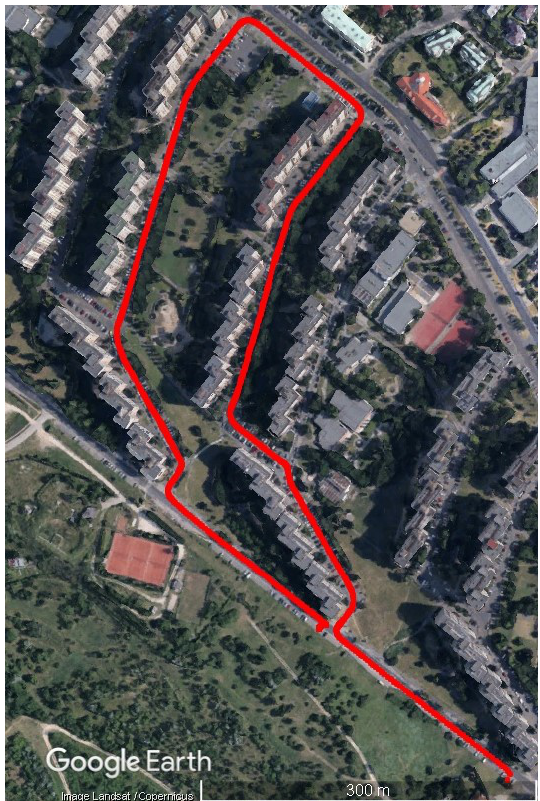
Figure 8. Trajectory of the urban canyon